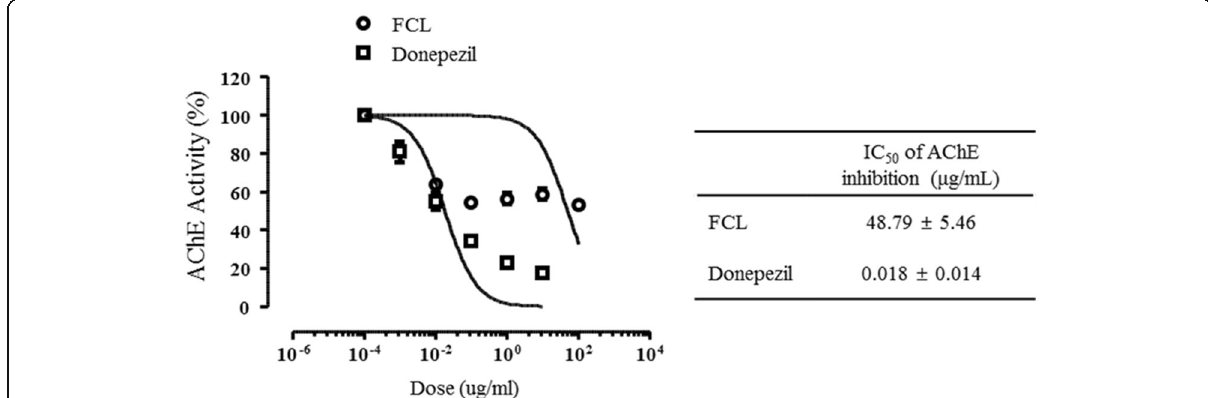
Fig. 4 Inhibitory effects of FCL or donepezil on AChE activity in vitroAChE activities were measured using acetylcholine iodide as a synthetic substrate in a colorimetric assay. Each AChE activity was observed in three times. AChE inhibition is expressed as mean ±